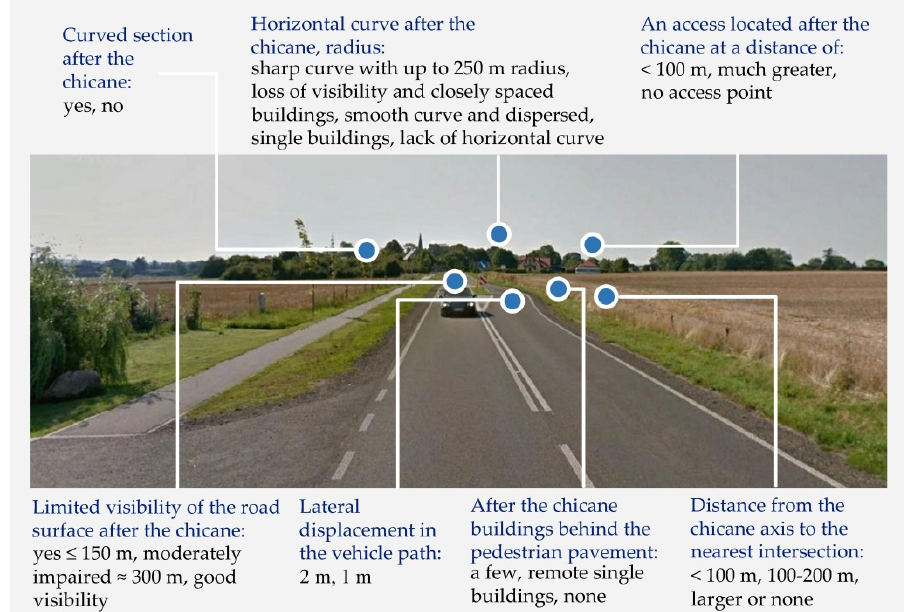
Figure 8. Factors related to the road design parameters chosen for the analyses (blue font designates qualitative factors and the black font designates the adopted interpretation of the quantitative measure).